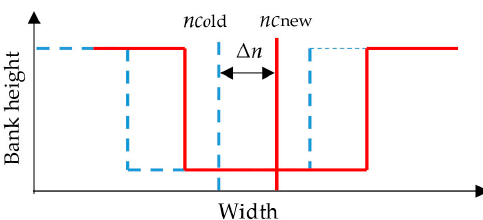
Figure 2. Cross centreline migration (Blue: old cross section, red: New cross section).